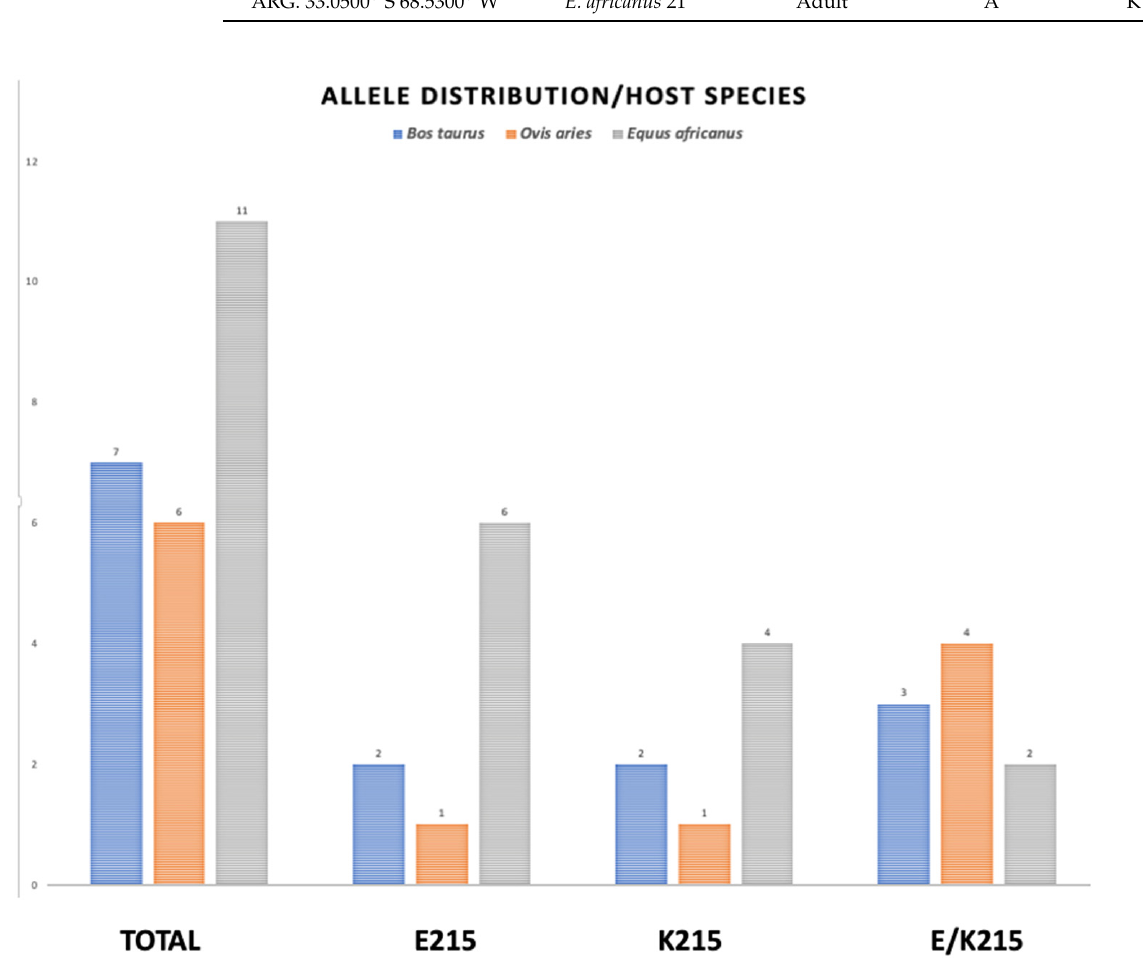
Figure 4. Allele distribution of amino acid substitution at position 215 in three different host species. The genomic DNA from two different developmental stages of F. hepatica , were submitted to PCR amplification of CestB gene and the resulting amplicons were sequenced and translated to their AA sequence and the amino acid located at position 215 determined as indicated above. The parasites obtained from B. taurus are represented by blue bars, those obtained from O. aries are represented by orange bars and the grey bars represent those parasites obtained from E. africanus .